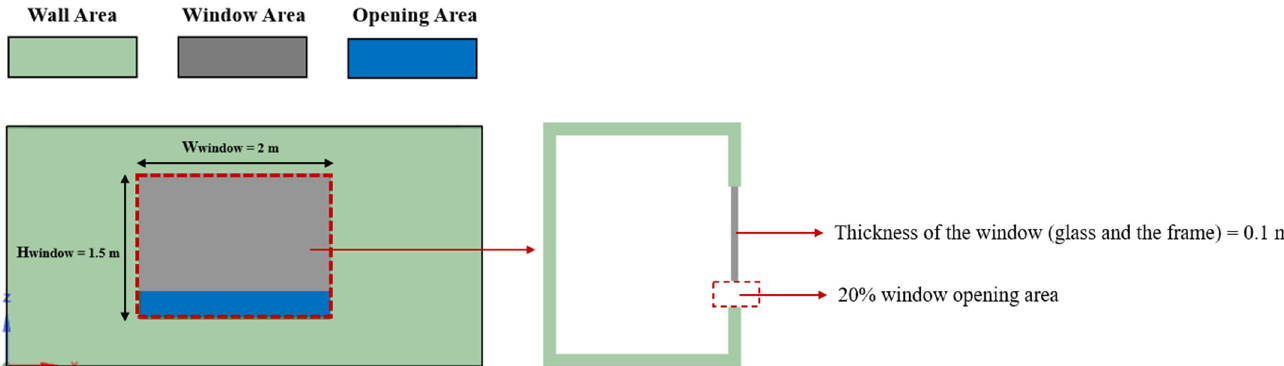
Figure 4. The dimension of each room, naturally ventilated by a window facing the courtyard.